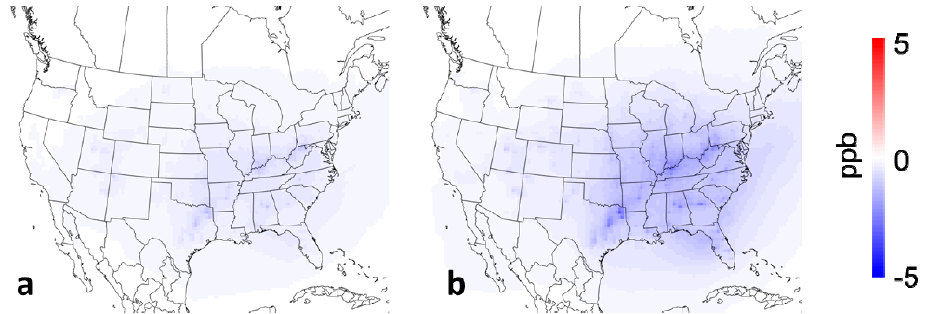
Figure 6. Difference in seasonal average maximum 8 h ozone average concentrations in ppb, across the domain for the year ( a ) 2030 and ( b ) 2050 between BAU and CES40B. PM 2.5 reductions tend to be more drastic, with an average of 0.5 μ g m − 3 less PM 2.5 in the eastern US by 2030 (Figure 7b), and up to 1 μ g m − 3 by 2050 (Figure 7b), which is on par with highest-ambition policies. The spatial pattern of reductions is identical to other policies considered (Figure 4).